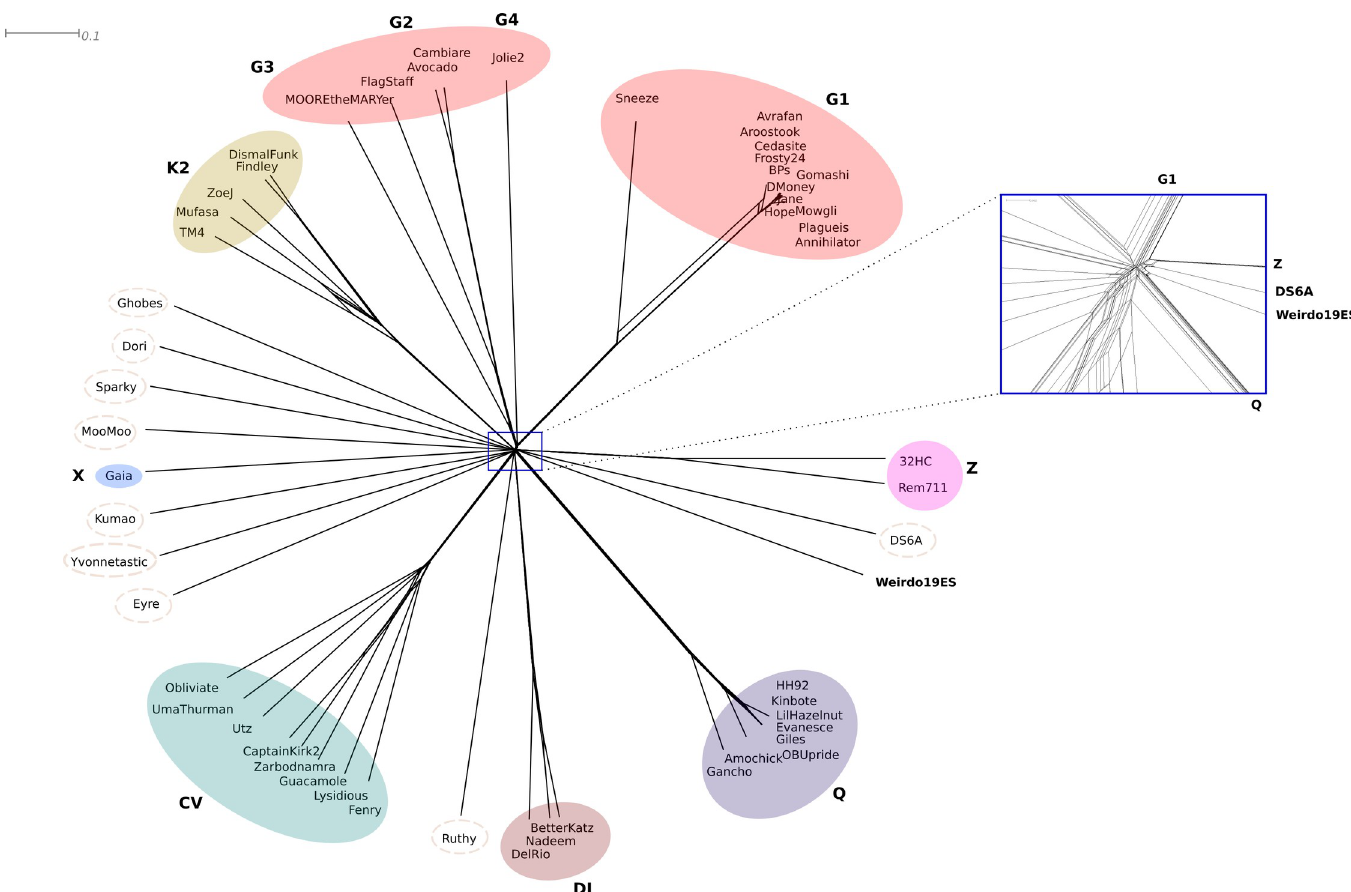
Fig 5. Phylogenetic network of mycobacteriophages. Gegenees was used to calculate the distance between bacteriophages and the phylogenetic network was build using the Neighbor-Net algorithm in Splitstree 4. The different clusters of bacteriophages were represented in different colors. The center of the network was zoomed in to analyze the most distant